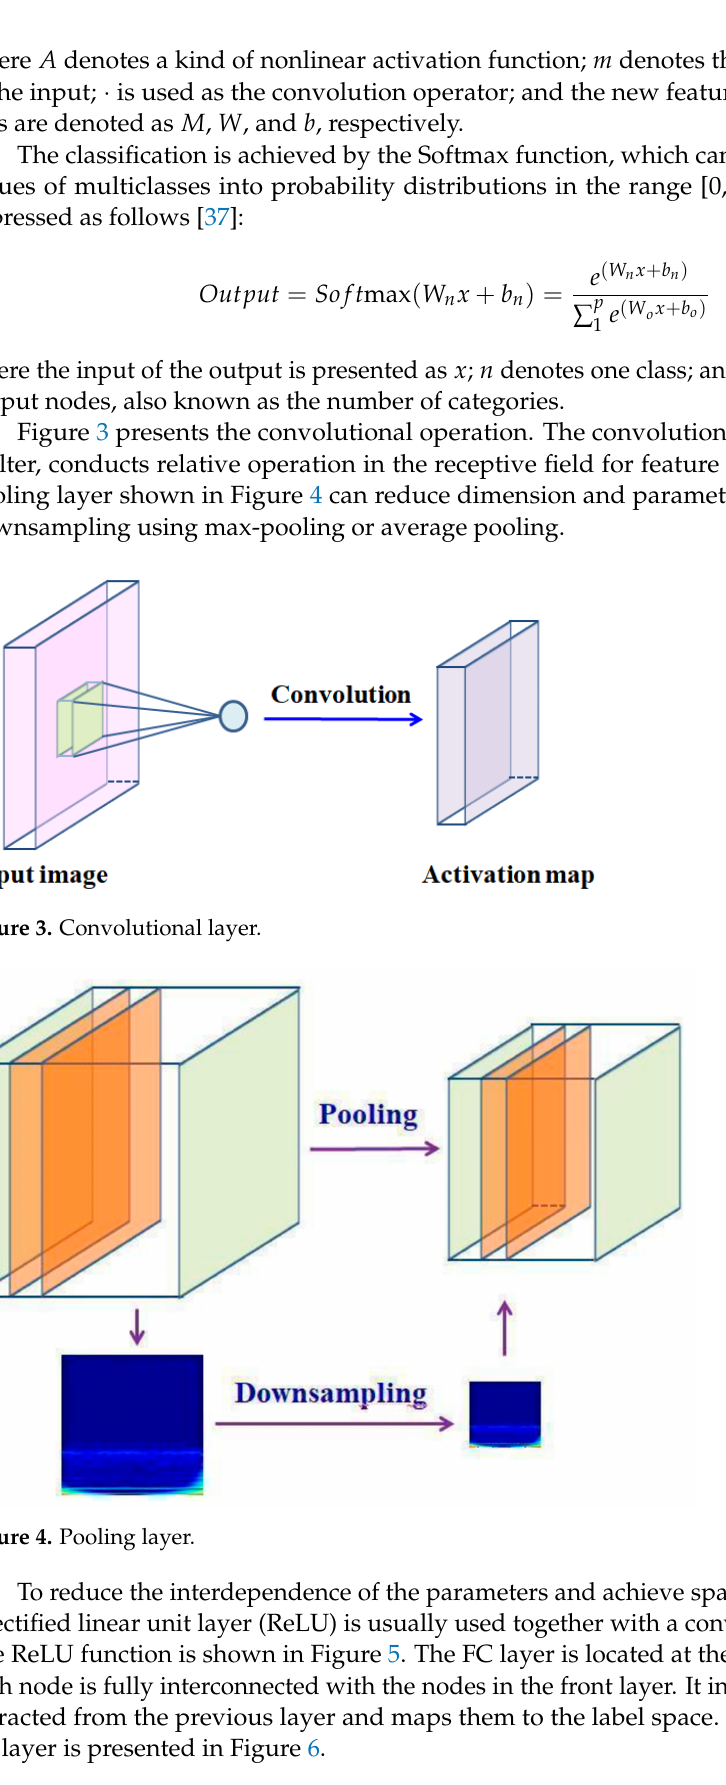
Figure 5. ReLU function.